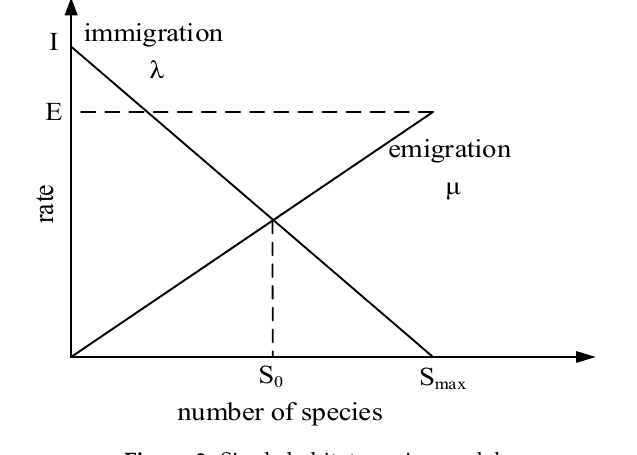
Figure 3. Single habitat species model.